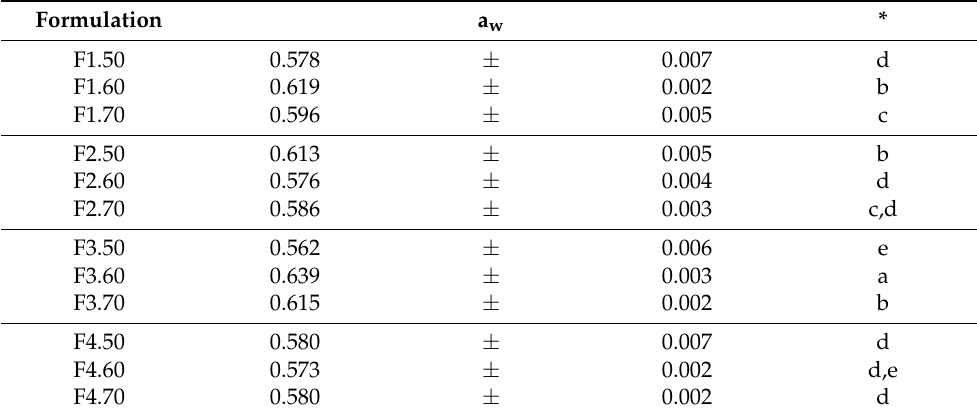
Table 4. Water activity of prepared edible films.